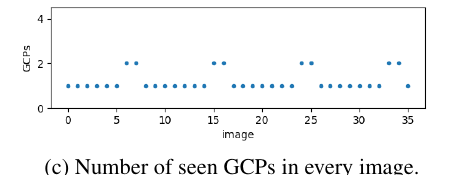
Figure 4. Results of visual localization with regularly spaced tie points and static GCPs.